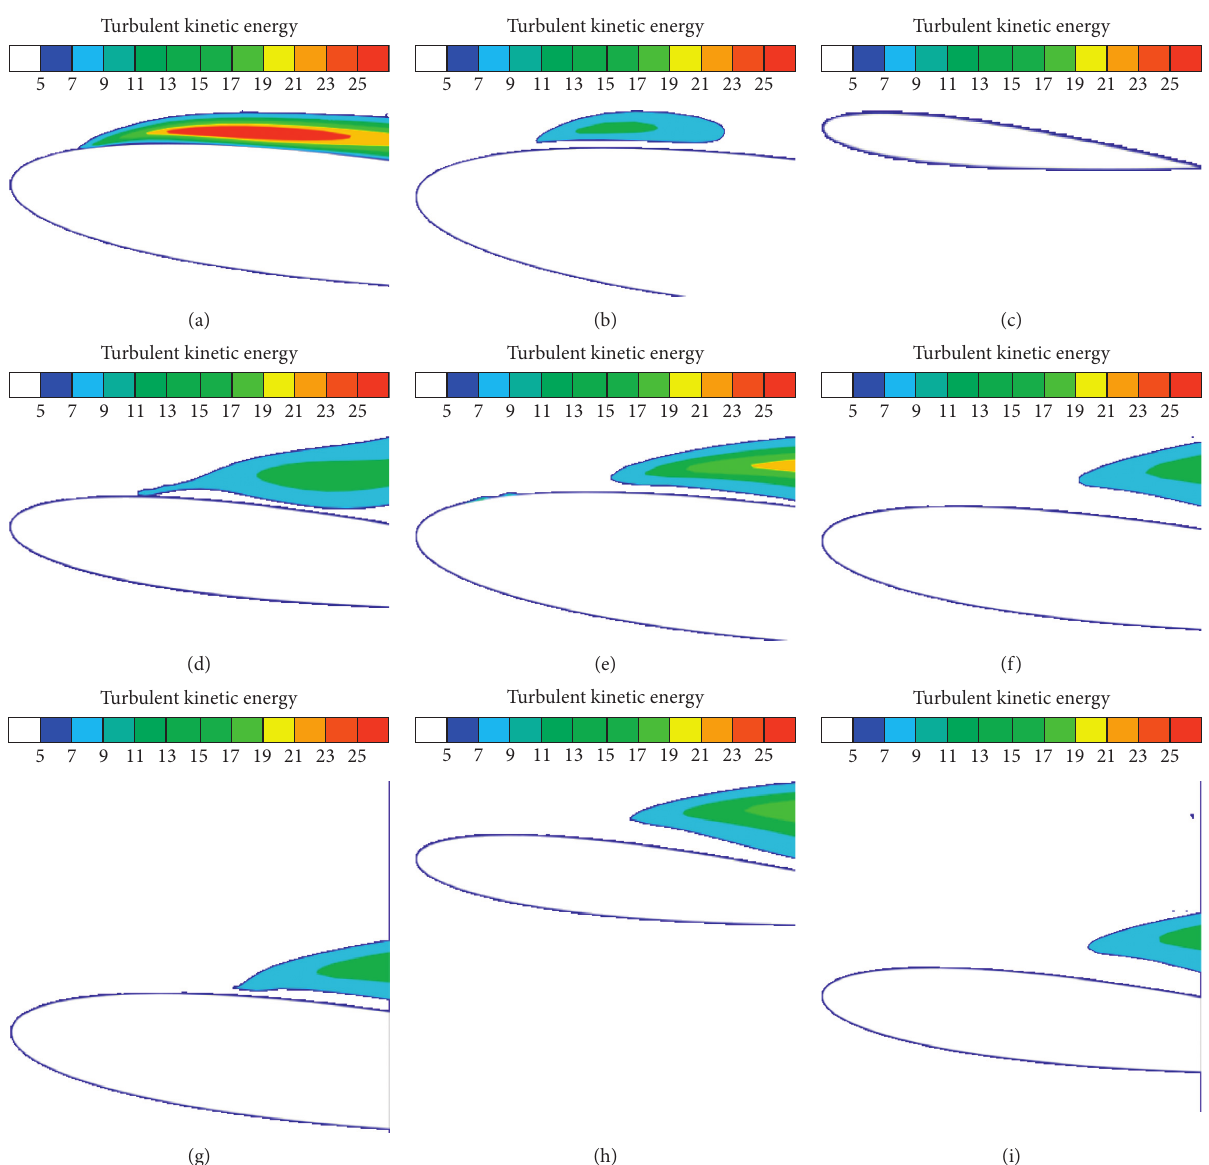
Figure 8: Turbulent kinetic energy nephogram of NACA hydrofoil with microchannel. (a) 5 ∼ 2 turbulent kinetic energy nephogram. (b) 5 ∼ 4 turbulent kinetic energy nephogram. (c) 5 ∼ 6 turbulent kinetic energy nephogram. (d) 10 ∼ 2 turbulent kinetic energy nephogram. (e) 10 ∼ 4 turbulent kinetic energy nephogram. (f) 15 ∼ 2 turbulent kinetic energy nephogram. (g) 15 ∼ 4 turbulent kinetic energy nephogram. (h) 20 ∼ 2 turbulent kinetic energy nephogram. (i) 20 ∼ 4 turbulent kinetic energy nephogram. Table 2: The factors and levels of the orthogonal test. Parameters Value Inflow velocity 15m/s,